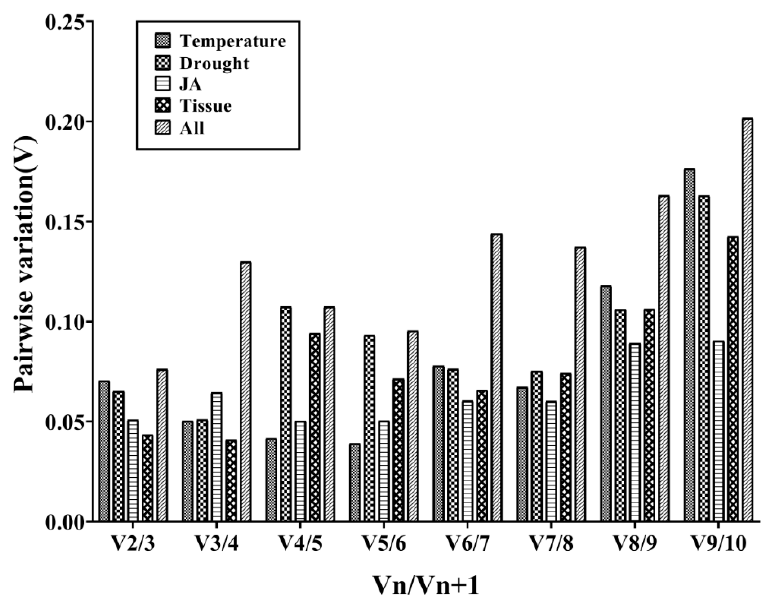
Figure 3. Determination of the optimal number of RGs for normalization by pairwise variation (V) using geNorm. The average pairwise variations (Vn/Vn+1) were analyzed to measure the effect of adding RGs during the RT-qPCR.